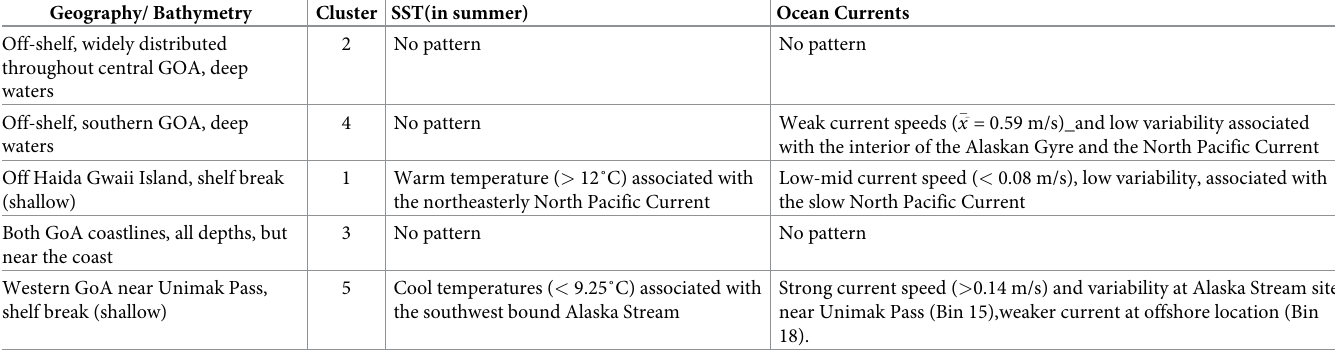
Table 3. Description of geophysical characteristics associated with each identified zooplankton community cluster. Geography/ Bathymetry Cluster SST(in